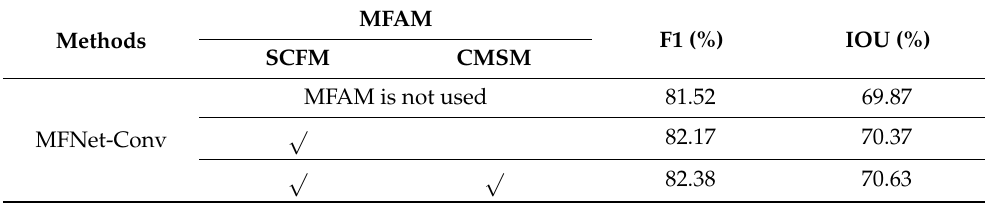
Table 8. Results of ablation experiments of CMSM in